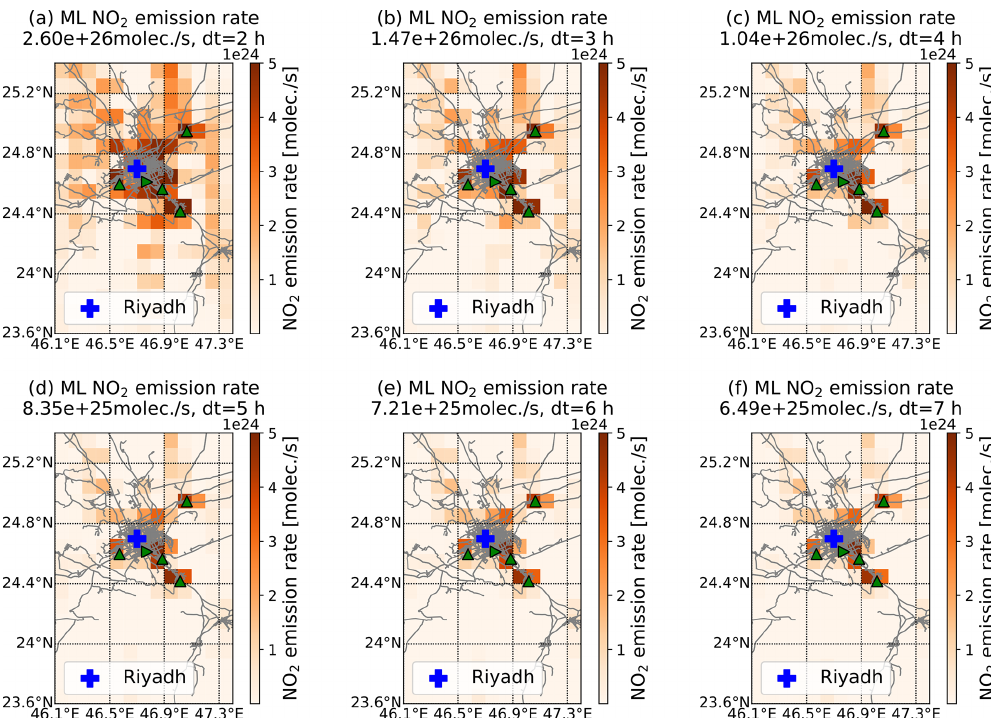
Figure A16. Estimated emission rates in Riyadh for a different decay time ( τ ) from 1 to 7h. Note that the color bars are different from that in Fig. 1d in order to cover a larger